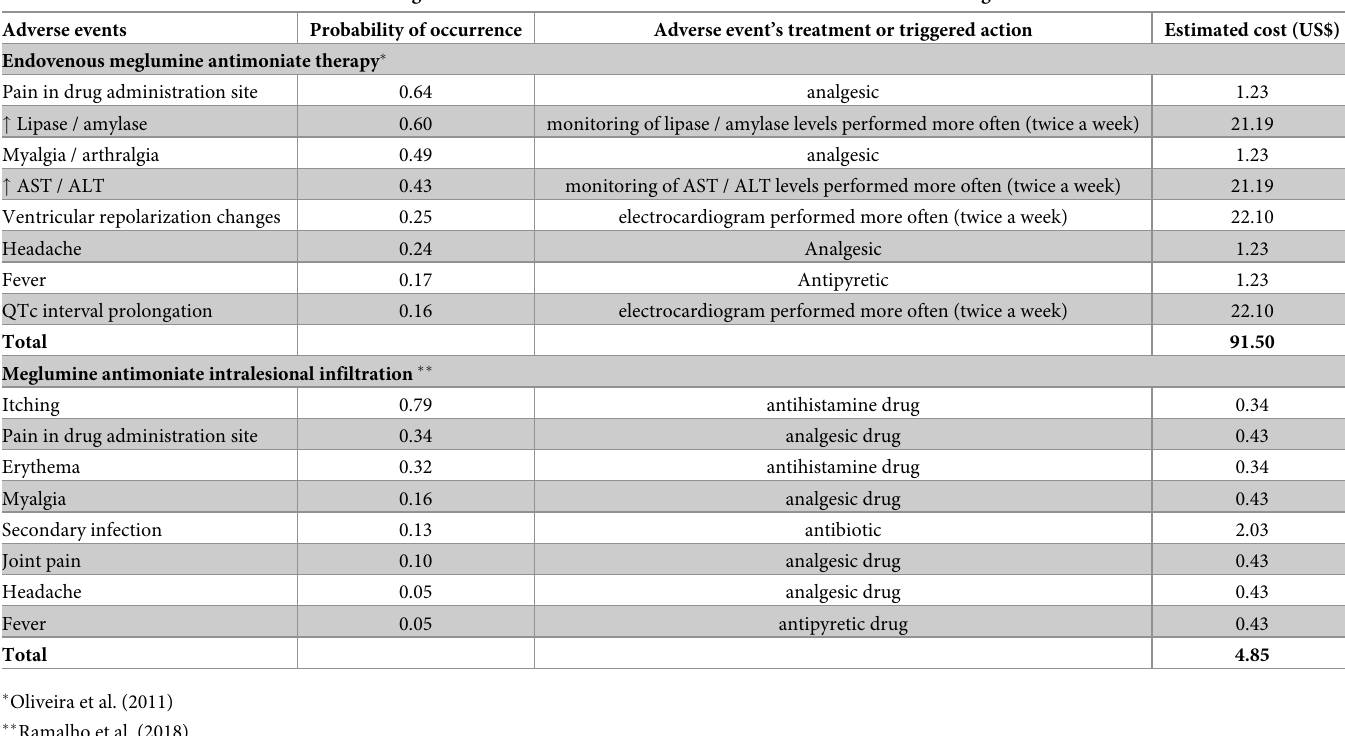
Table 2. The costs related to adverse events to meglumine antimoniate intralesional infiltration and to endovenous meglumine antimoniate treatment. Adverse events